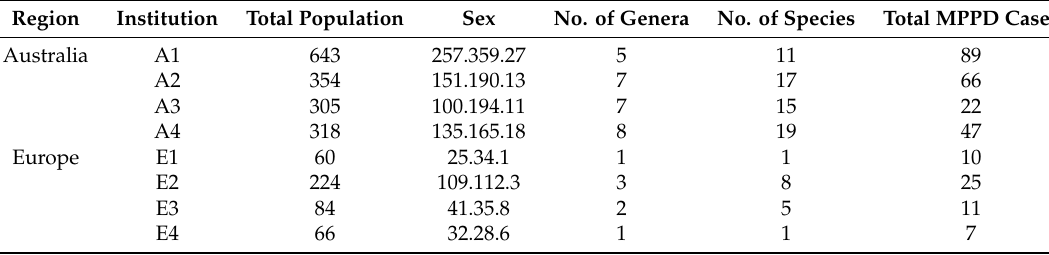
Table 1. Summary of macropods housed at eight zoological institutions across Australia and Europe between 1 January 1995 and 28 November 2016. MPPD = Macropod Progressive Periodontal Disease. For sex, ‘m’ = male, ‘f’ = female, and ‘ud’ = undetermined.